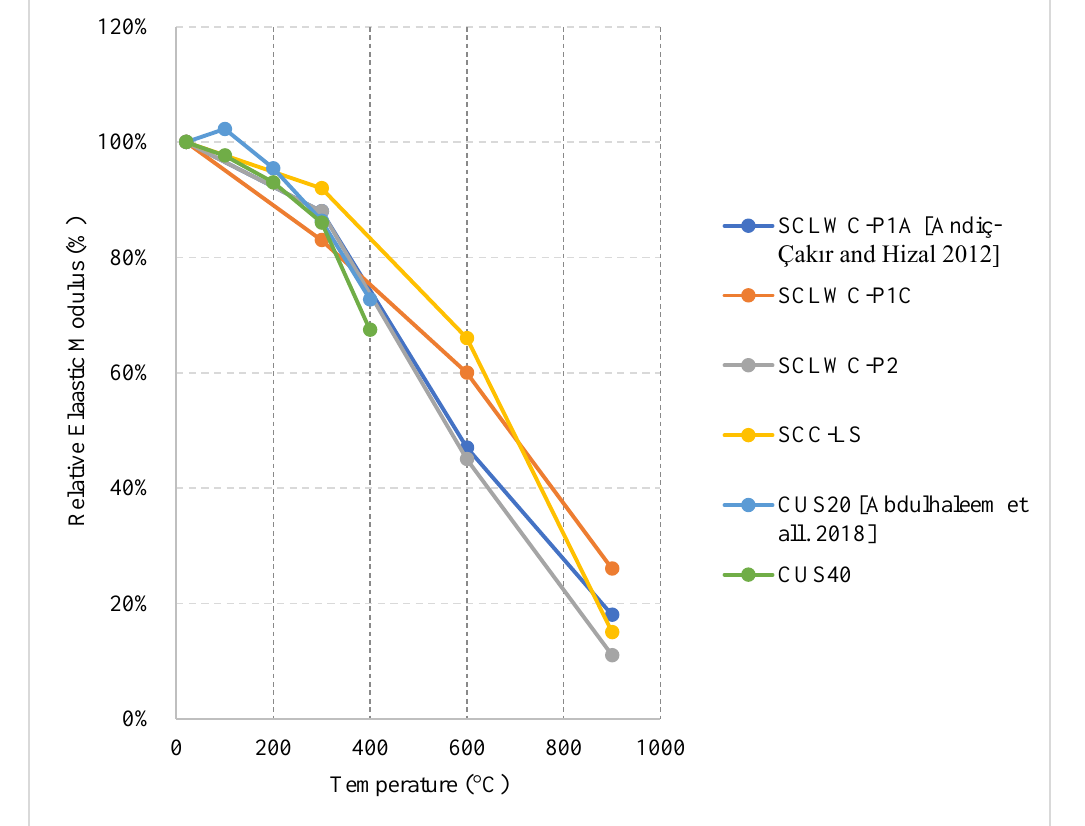
Figure 44. Relative Elastic modulus of different naturally cooled SCC mixes. P1A = Pumice aggregates (4–16 mm) with 0.42 w/c ratio, P1C = Pumice aggregates (4–16 mm) with 0.35 w/c ratio, P2 = Pumice aggregates (4–8 mm and 8–16 mm) with 0.35 w/c ratio, LS = Limestone aggregates, CUS20 = 20% copper slag replacement, CUS40 = 40% copper slag replacement [102,103].